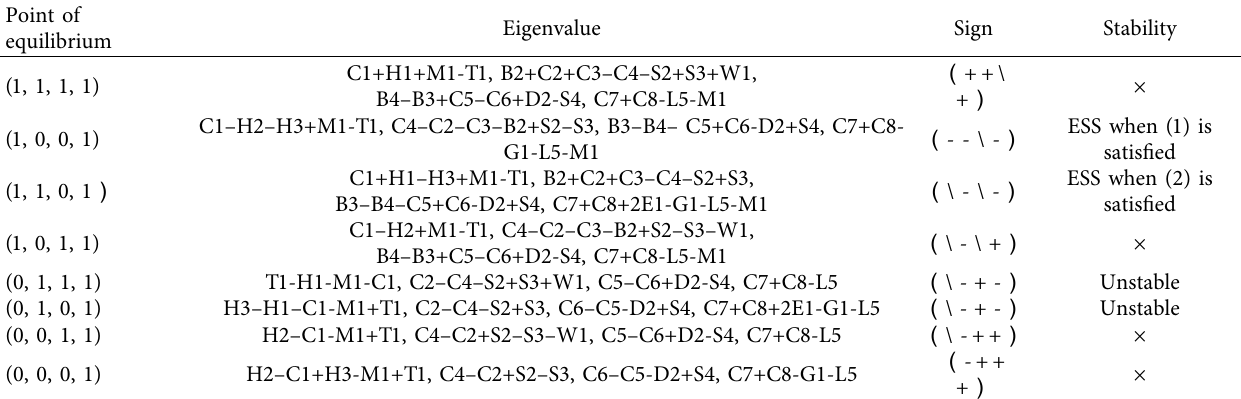
Table 2: Analysis of the gradual stability of the equilibrium point of the replication dynamic system under the hard work of the enterprises. Point